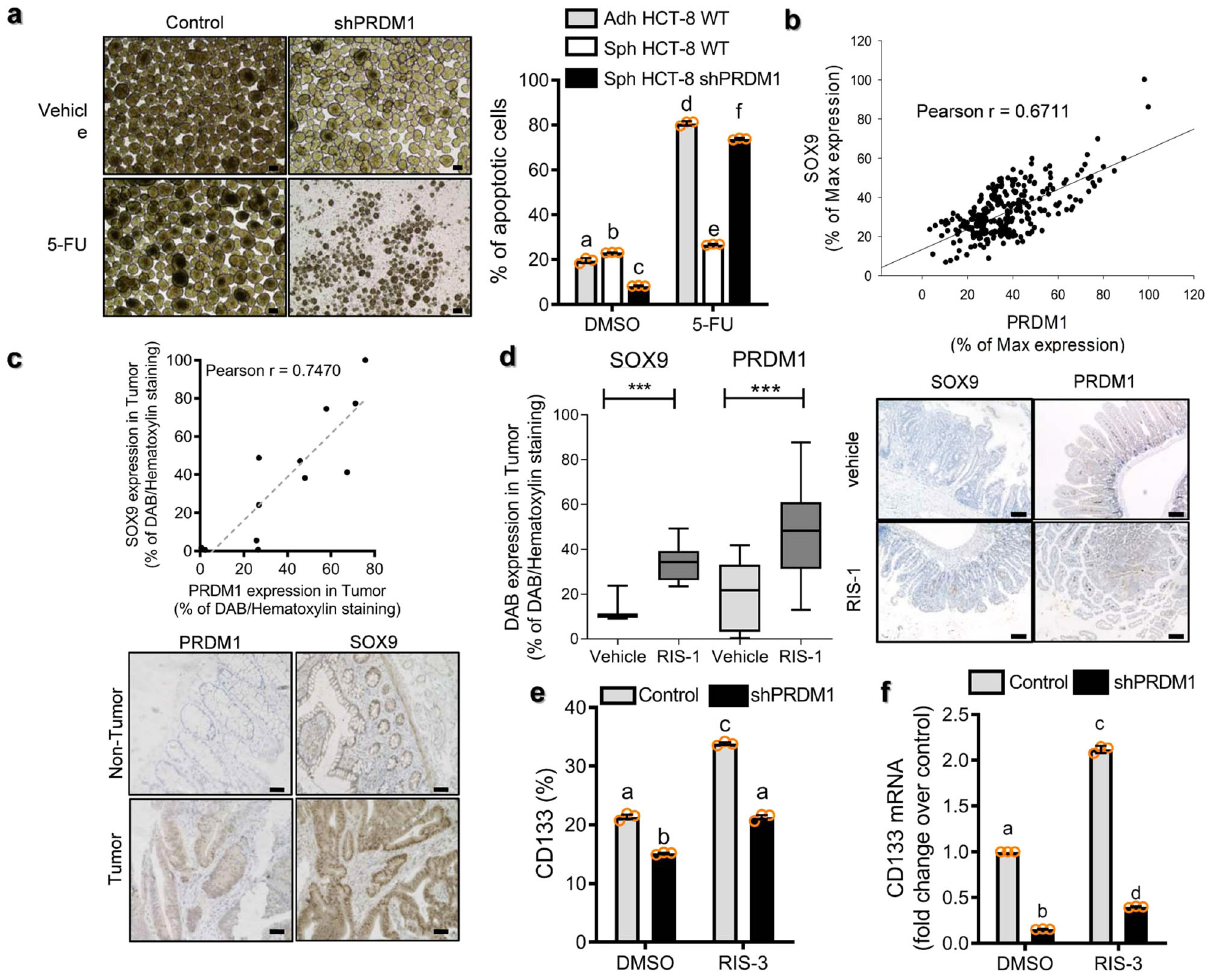
Fig. 8 Correlation between PRDM1 and stemness biomarkers in human CRC tissues and APC Min/ + mice. a The intestinal cancer cell lines (the negative control plasmid- or shPRDM1-expressing HCT-8) were treated with DMSO or 375 μ M 5-FU in the state of adherent cells (Adh) and spheroids (Sph). Cellular apoptosis was quanti fi ed (the right graph) and spheroids were visualized (the left). Results are shown as mean values± SD and different letters (a – f) over each bar represent signi fi cant differences between groups ( n = 3, P < 0.05). The microscopy analysis was performed at original magni fi cation ×100; scale bar(s), 50 μ m. b Correlations between SOX9 and PRDM1 mRNA expression in CRC patients (TCGA 286, ID: COAD, n = 286) were calculated using a two-tailed Pearson correlation test. c Histological sections of human CRC tissues were analyzed by immunohistochemistry against PRDM1 and SOX9. Correlations between SOX9 and PRDM1 protein expression in CRC patients ( n = 12) were calculated using a two-tailed Pearson correlation test. The representative microscopic observation was demonstrated at the original magni fi cation ×200; scale bar(s), 50 μ m (lower panels). d APC Min/ + mice received the vehicle or 25 mg/kg RIS-1 via oral gavage and at 72 h later the small intestine was examined by immunohistochemistry. Results are shown as a plot with Tukey whiskers and asterisks represent a signi fi cant difference relative to the vehicle group ( n = 3 – 15, *** P < 0.001). The representative microscopic observation was demonstrated at the original magni fi cation ×100; scale bar(s), 50 μ m (right panels). e , f Human CRC cell spheroids from the negative control plasmid- or shPRDM1-expressing HCT-8 (2 × 10 5 ) were treated with ID 90 of RIS-3 for 24 h to assess levels of each marker. CD133-positive populations of CD133 ( e ) and mRNA levels of CD133 ( f ) were measured. Results are shown as mean values ± SD and different letters (a – c) over each bar represent signi fi cant differences between groups ( n = 3, P <